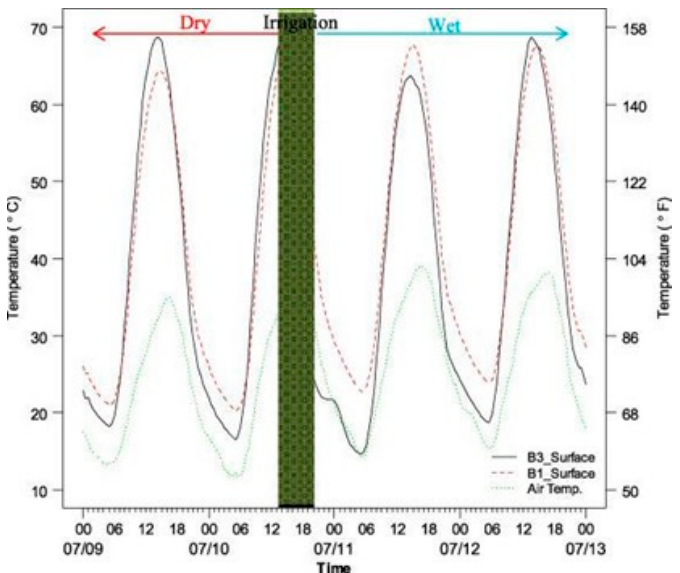
Figure 10. Thermal performance of permeable pavement (B3) with and without irrigation compared to the impermeable pavement (B1) for four days in July 2012 (the time unit above mm/dd indicates hours with 00 representing midnight) [71].